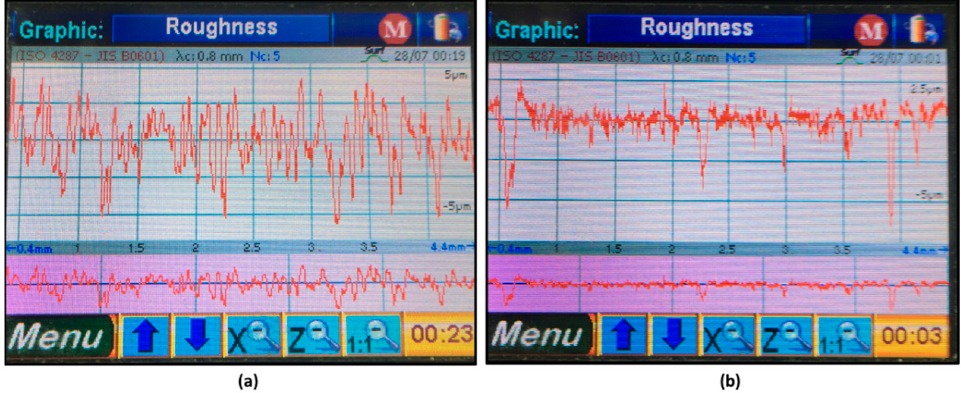
Figure 15. Generated surface roughness of the optimal parameter set for: ( a ) conventional insert and ( b ) wiper insert.